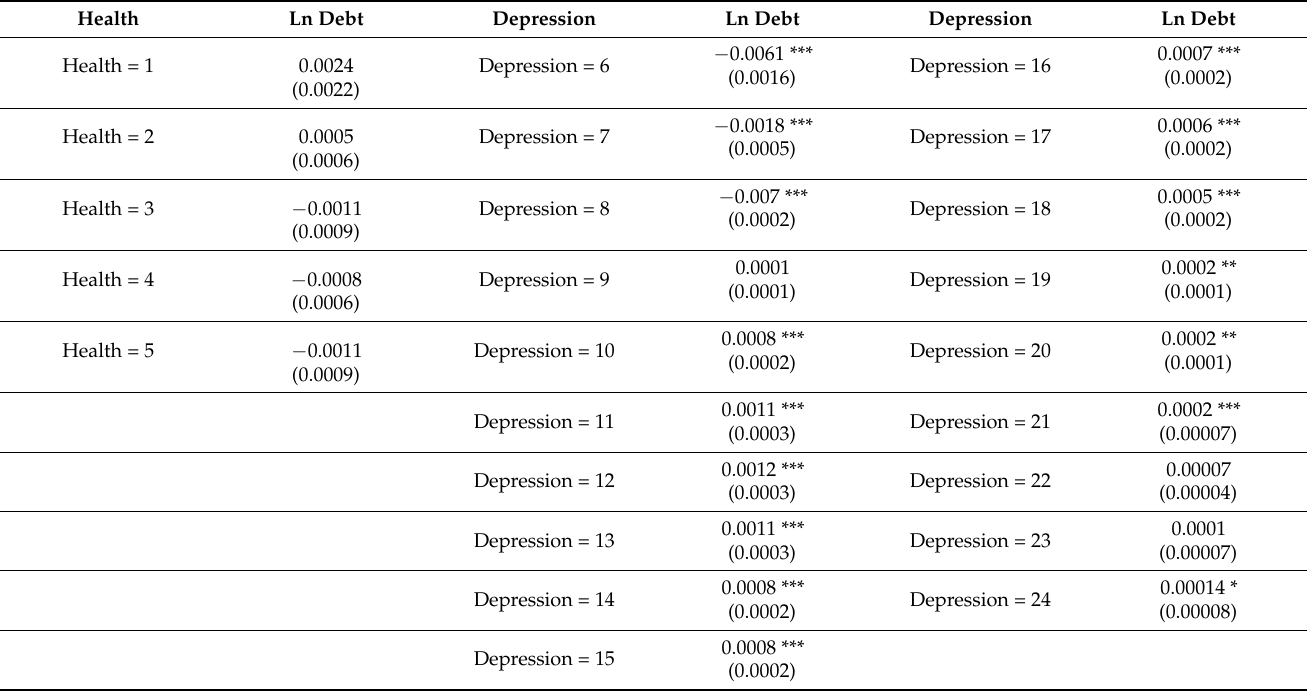
Table A4. Marginal effects of household debt in medium education